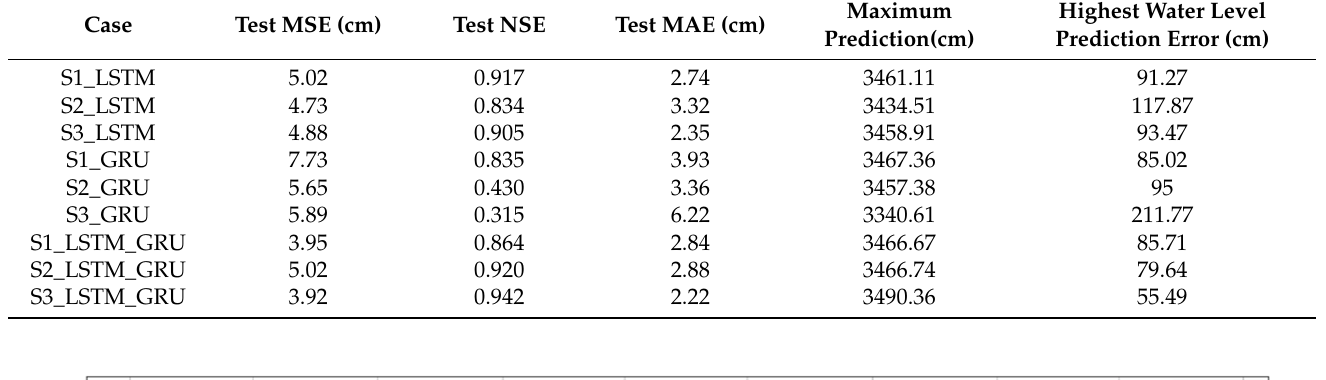
Table 4. Test results.